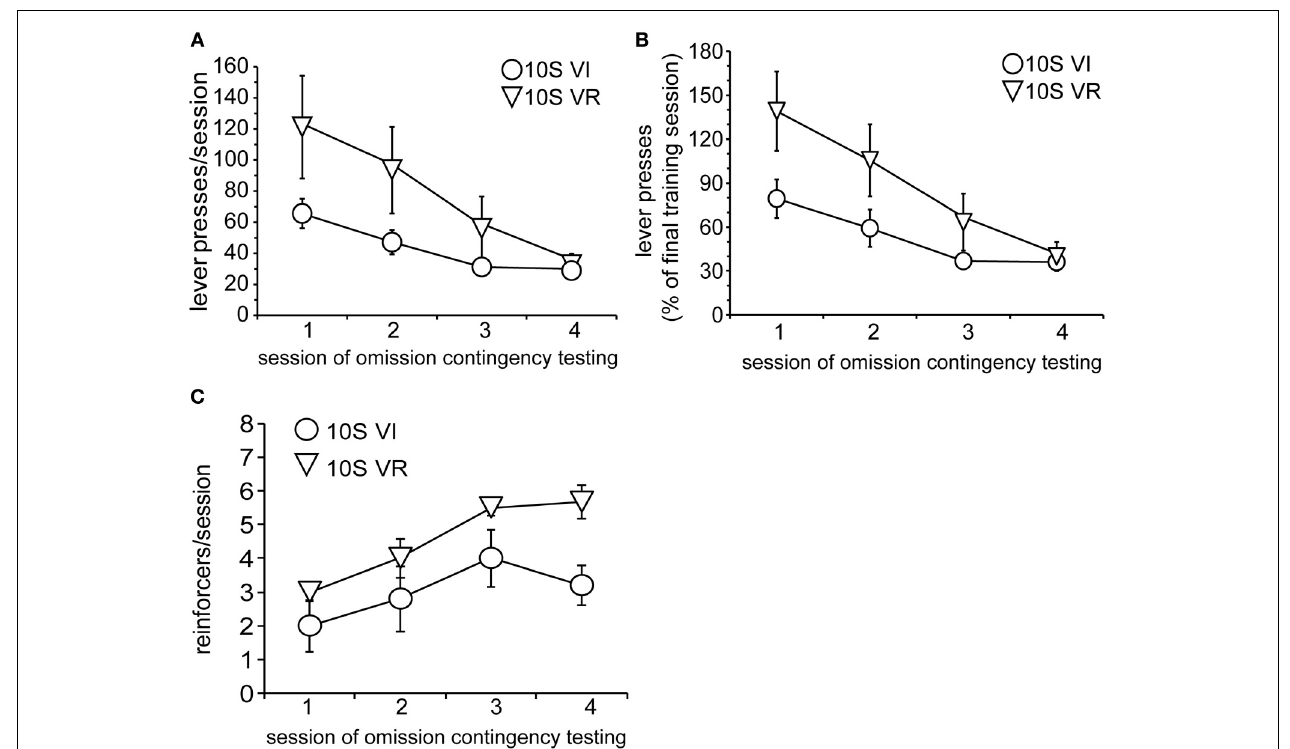
FIGURE 5 | Testing of 10S groups. (A) Decay in the number of lever presses per session was similar for the 10S VI (circles) and 10S VR (triangles) groups across testing. (B) The similar patterns of behavioral adaptation were still apparent when test performance